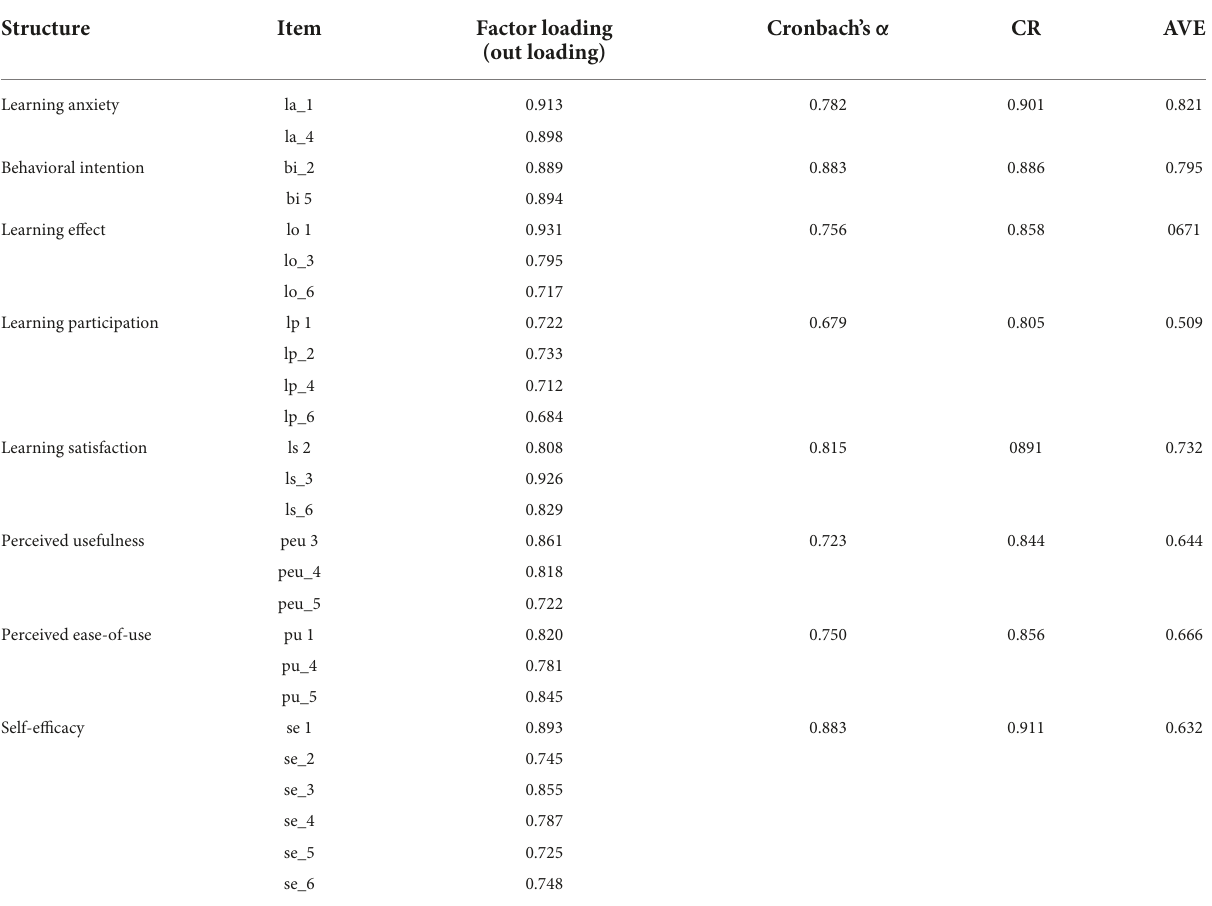
TABLE 2 The validity analysis of each structure from SPOC-AIoT learning scaling.